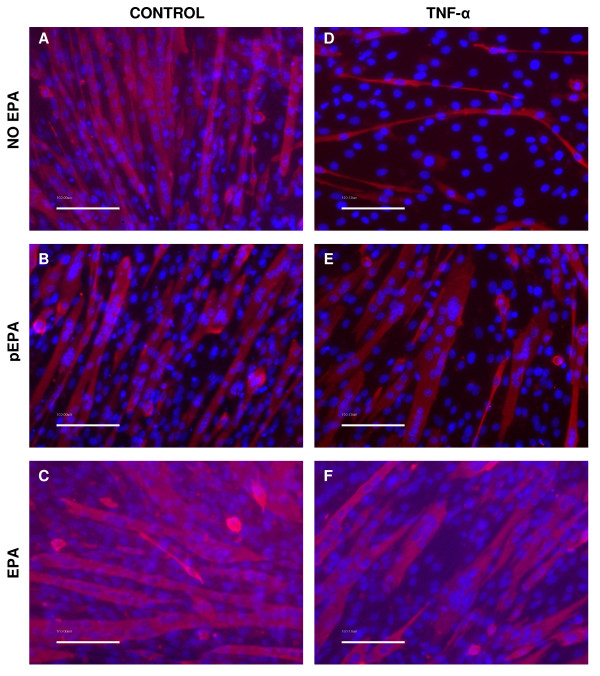
EPA ameliorates the effects of TNF-α on differentiating myotube appearance and MyHC expression. C2C12 cells were induced to differentiate in DM in the presence or absence of TNF-α (20 ng/ml). EPA (50 μM) was added together with TNF-α as a co-treatment (EPA). Alternatively, for some experiments EPA was administered alone for a 2 hour pre-treatment (pEPA) after which it was withdrawn and replaced by TNF-α alone in DM. Incubations were continued for 5 days in DM with replenishment of EPA and TNF-α at media changes. Representative images show immunofluorescence detection of Alexa-Fluor546 conjugated anti-MF20 antibody against MyHC (pink) and DAPI counterstained nuclei (blue) for various treatments with EPA and TNF-α. Control treatments are shown in the left panel images and TNF-α treatments in the right panel images. Calibration bars are 100 μm.